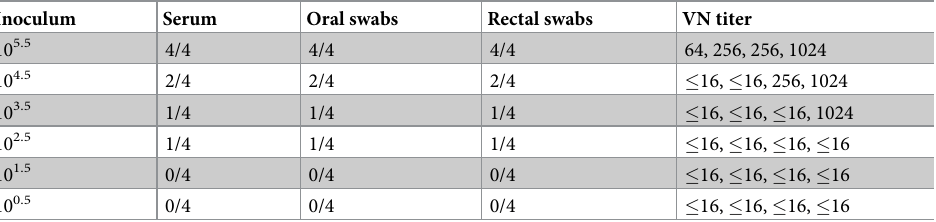
Table 4. Summary of neonate PCR positive status for each sample type on 6 dpi and VN titer for 10 dpi serum.